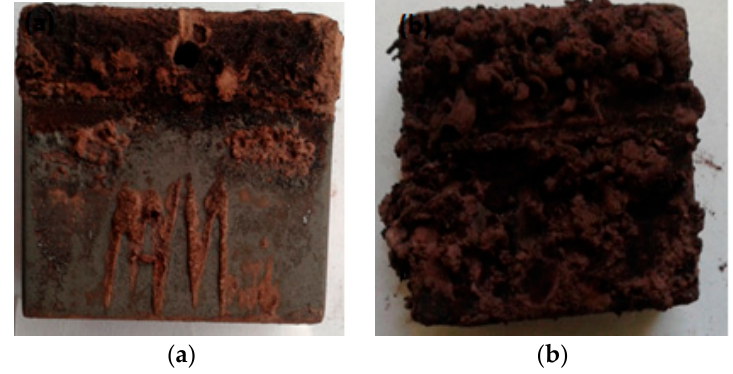
Figure 5. Visual appearance of MAS exposed to ethanol fuels at 27 °C after 60 days. ( a ) E80 + 0 mg/L NaCl; and ( b ) E80 + 32 mg/L NaCl showing increased rust in the presence of chloride.